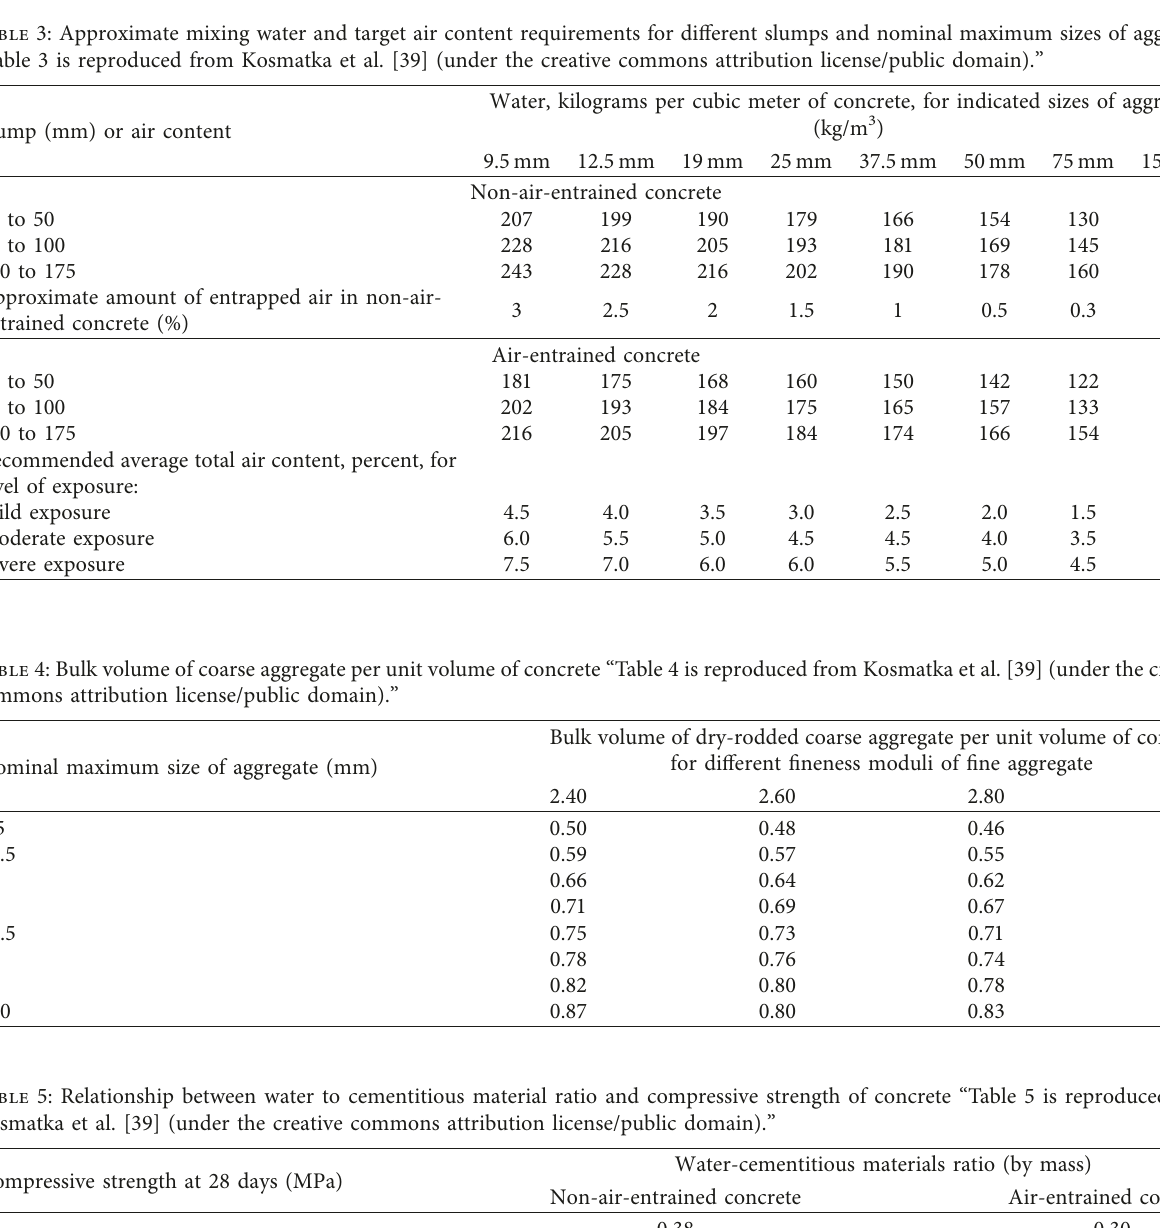
Approximate amount of entrapped air in non-air-